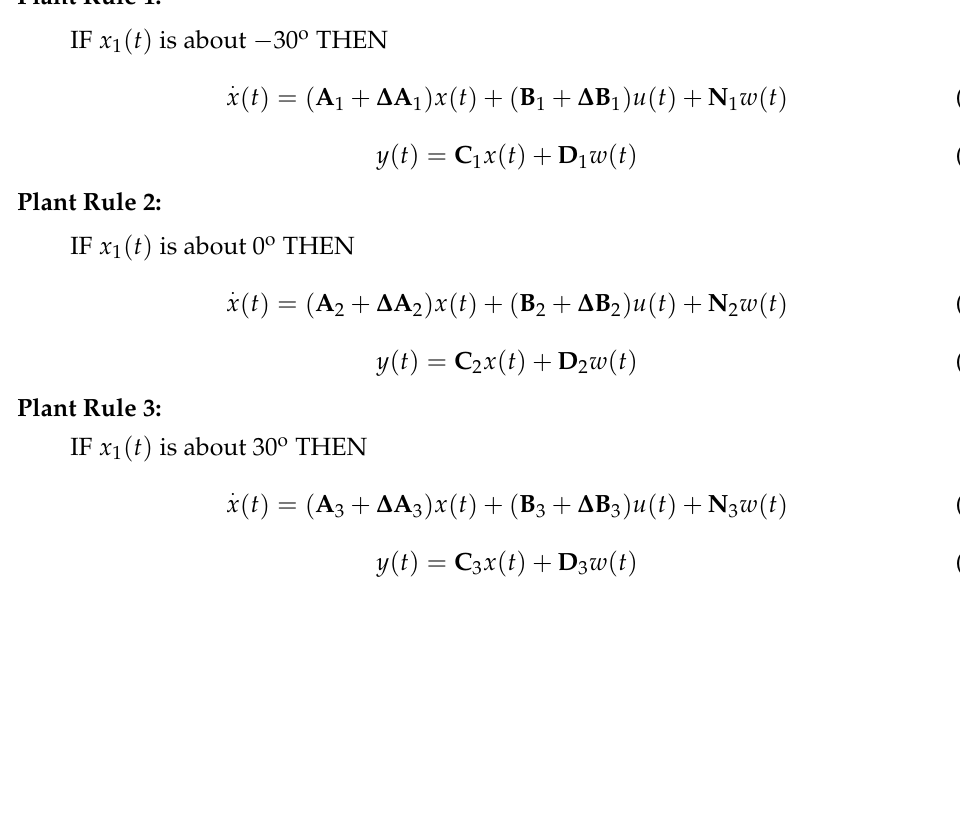
x t with three fuzzy rules. Figure 1. The membership functions of state x 1 ( t ) with three fuzzy 1